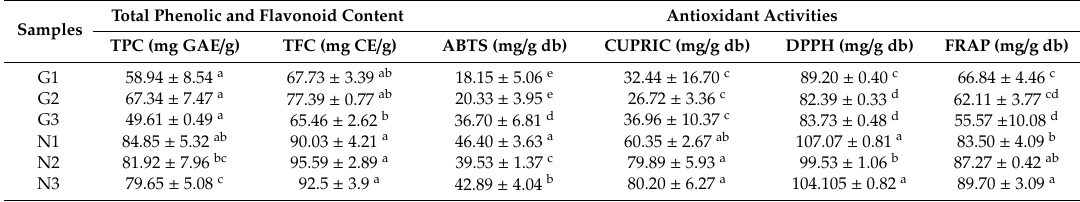
Table 3. Results of total phenolic and flavonoid content and antioxidant activities of representative X. aethiopica samples from Ghana and